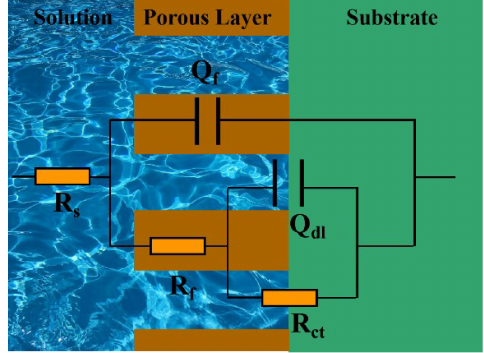
Figure 6. Equivalent circuit used to fit impedance data. Table 2. Equivalent circuit parameters for as-cold rolled and heat treated sheets in naturally aerated